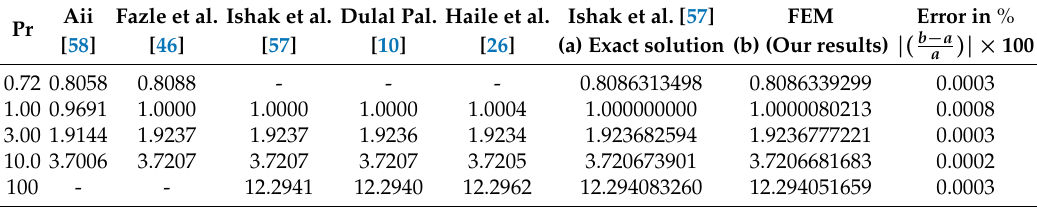
Table 5. Comparison of − θ (cid:48) ( 0 ) for various values of Pr ( M = f w = S θ = σ = λ 1 = λ 2 = λ 3 = R = Nd = k p = S f = 0;).